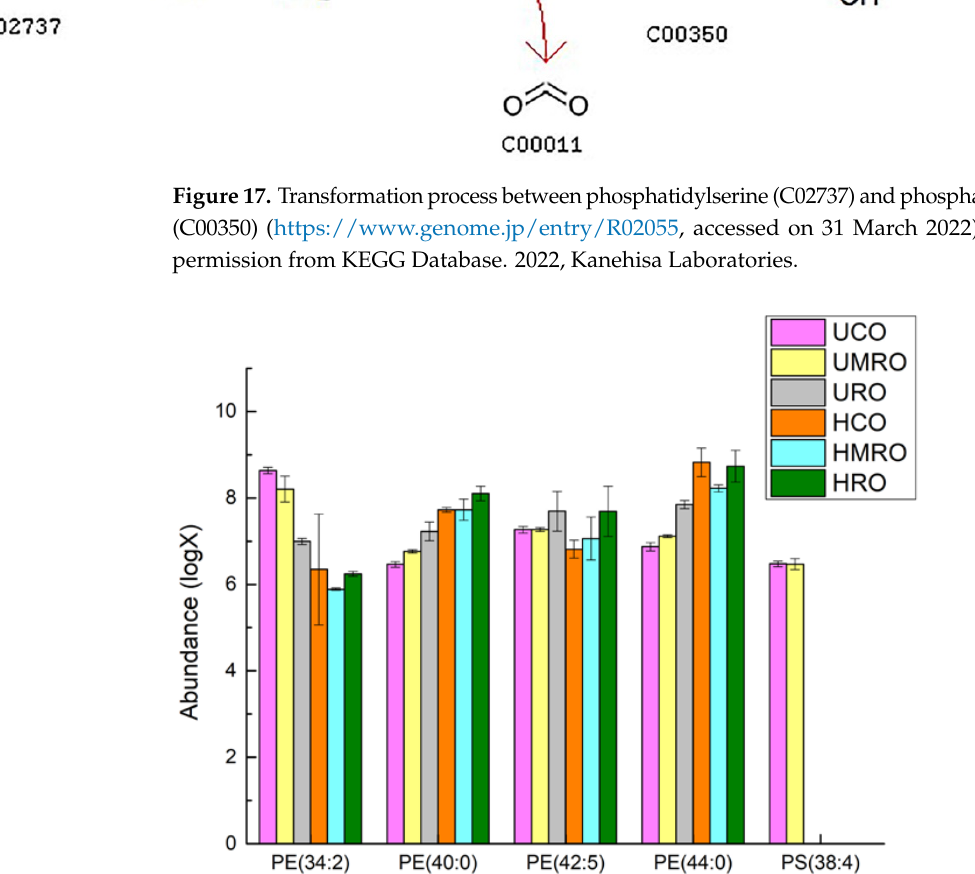
Figure 18. Effects of refining and heating on PE and PS.